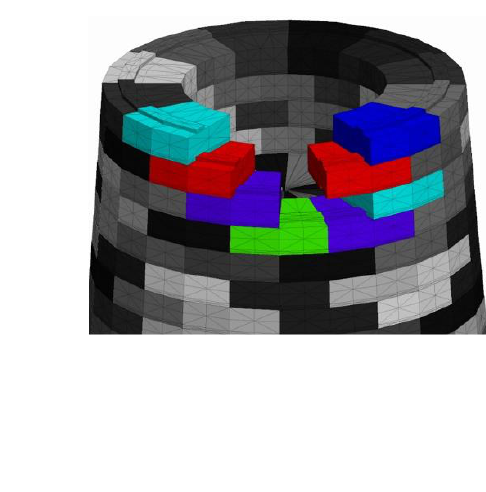
Figure 7. Pressure profiles in 3DEC: ( a ) distribution #1; ( b ) distribution #2; ( c ) distribution #3. 5. Structural Analysis and Results Figure 8 presents the structural response, in terms of horizontal and vertical displace- ment, of a control point on the crown of the tower. The three simulations yield similar responses qualitatively and quantitatively, with the maximum horizontal displacement ranging from 0.219 m to 0.230 m (a difference of up to 5%) and the vertical one between 0.098 m and 0.107 m (a difference of up to 9%). It is interesting to note a relatively high level of damping affecting the structural response before any resonance phenomena oc- cur. The main response outputs are presented in Table 1. Studies on the influence of the wave characteristics have revealed that the structural response of the lighthouse is heavily influenced by parameters such as the force – time history shape, duration and maximum force (Raby et al. (2019), Pappas et al. (2018) [1,2]). For a relative assessment, the current analysis results are compared with the ones manifested by a wave of maximum force